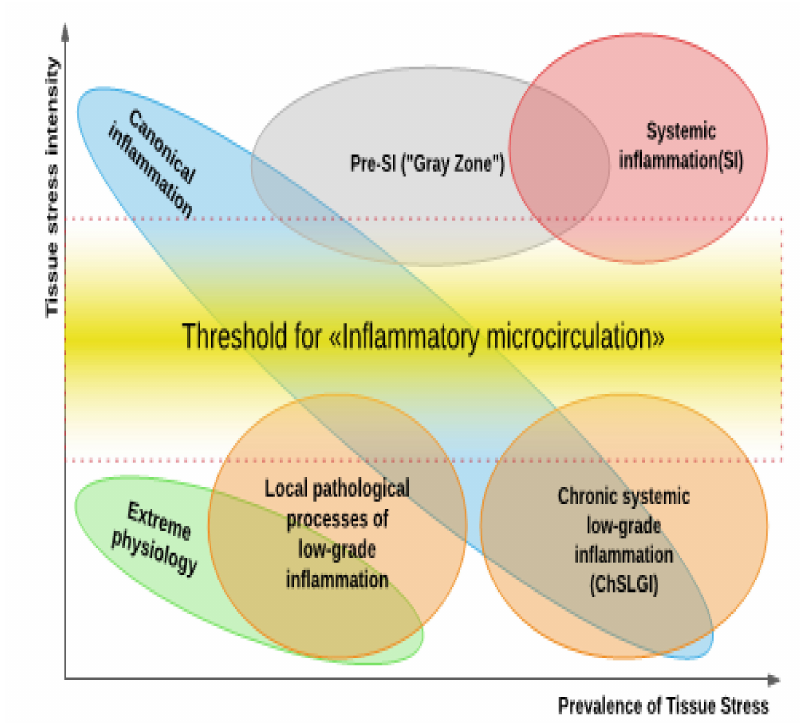
Figure 2. Tissue stress and general pathological processes. Three “large” general pathological processes can be distinguished based on the ratio of intensity (the ordinate in the Figure) to prevalence (the abscissa) of damaging factors initiating a “response” in the form of tissue pro-inflammatory stress—a common pathogenetic basis of all pathological processes (classical inflammation, SI, and ChSLGI). The “inflammatory microcirculation”—a reaction of microvessels that causes a clinically significant exudative reaction and enormous migration of leukocytes into a damaged area with the establishment of the inflammation focus—is the key differentiating phenomenon for their separation. (1) The existence of an inflammation focus (upper-left corner in Figure 2), as well as, in some cases, the systemic manifestations of tissue stress at a subthreshold level for “inflammatory microcirculation”, characterizes classic inflammation. In most cases, these systemic reactions are protective and targeted at providing resource support for the inflammation’s focal point (immune response, the acute-phase response of the liver, forced leuko-cytopoiesis, neuroendocrine stress, and mobilization of metabolic reserves). (2) Systemic inflammation (SI) is characterized by shockogenic systemic “inflammatory microcirculation” and the presence of a transitional “gray” zone, in which it is impossible to prove or refute the presence of SI in situations of the “pushing” variant development (upper-right corner of the Figure). (3) Parainflammation (low-intensity inflammation): can be local (see the figure in the lower-left corner of Figure 1) or can spread throughout the body (see ChSLGI) (lower-right corner of Figure 1). The signs of endotheliosis and, in certain circumstances, latent microcirculatory